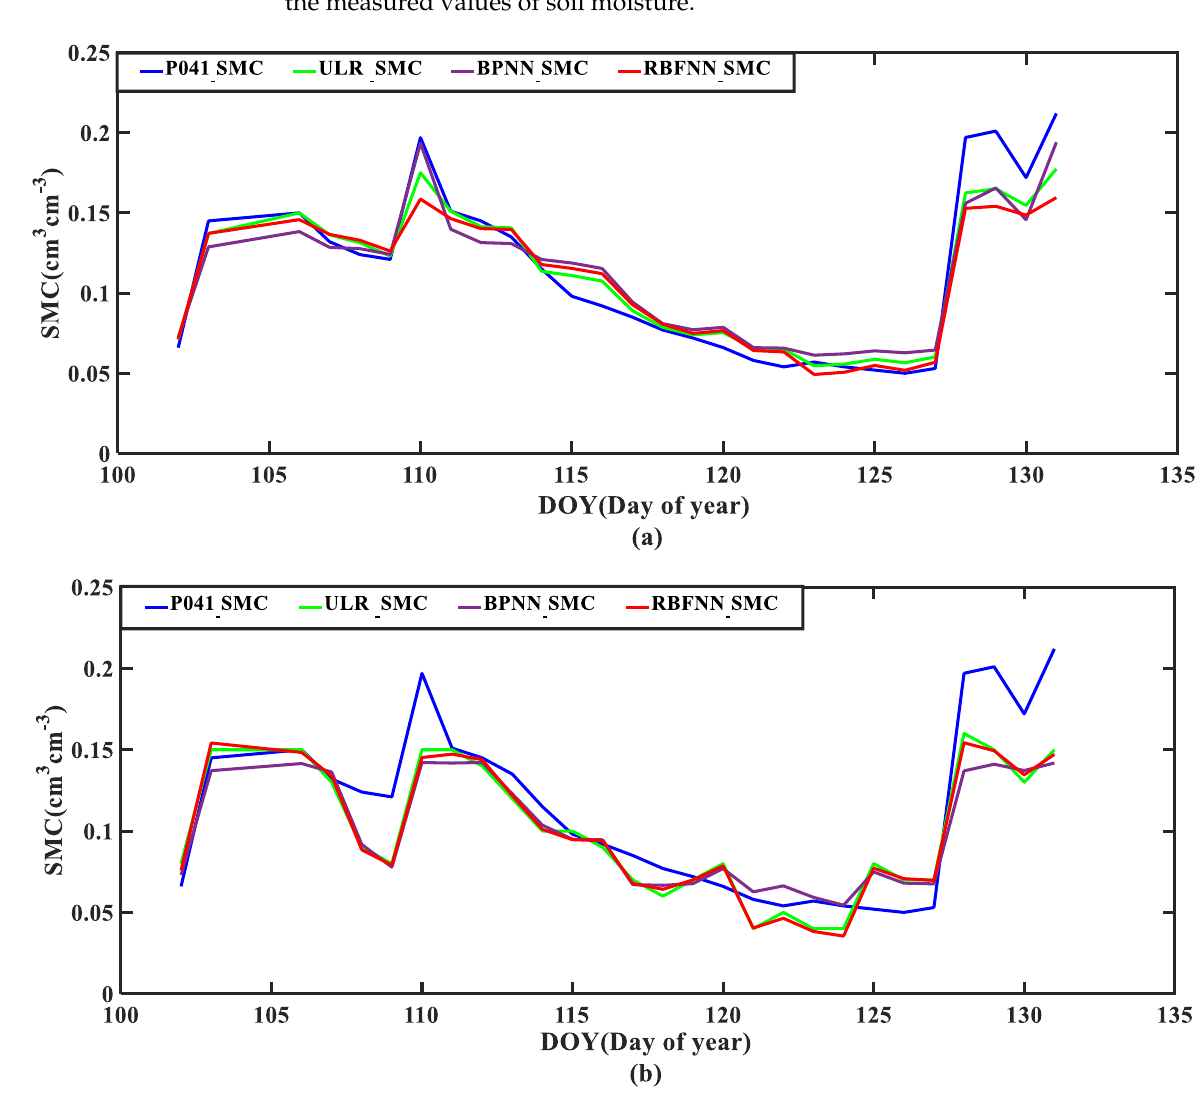
Figure 16. For P041 station; comparison between the predicted values of three models and measured